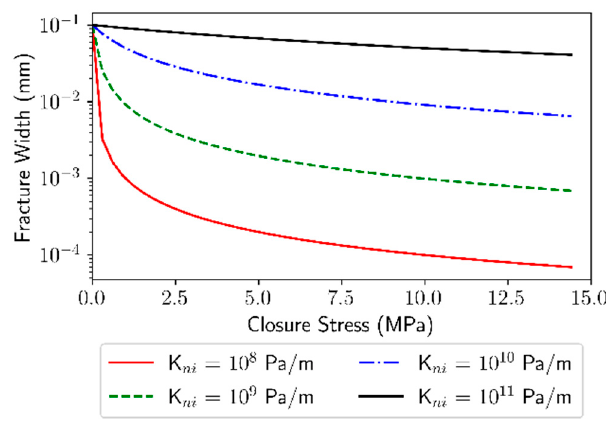
Figure 10. Fracture closure rate is controlled by stiffness (K ni ).